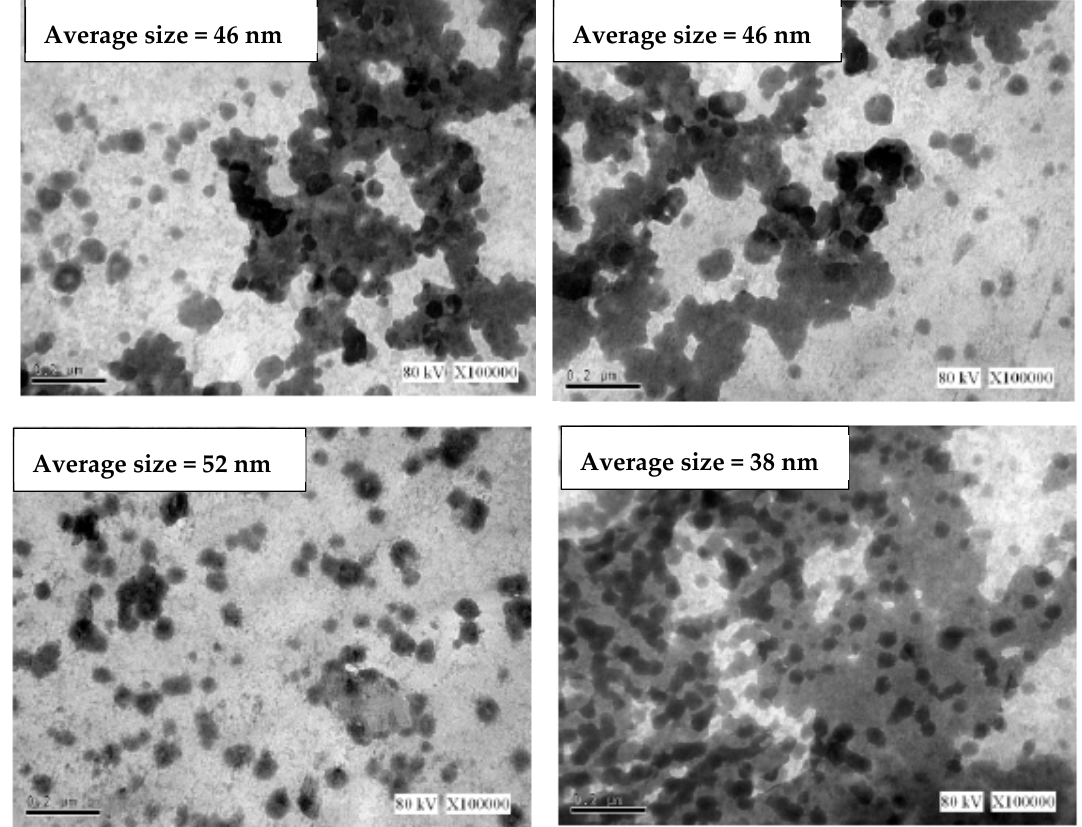
Figure 6. TEM image of nPOFA with average particle size at different locations [28].